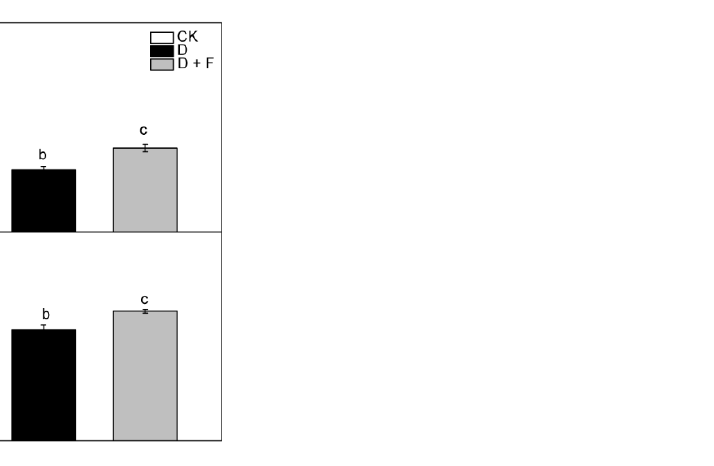
Figure 1. Aboveground biomass ( a ) and leaf relative water content ( b ) in leaves of B. napus treated with different fullerol treatments (0 and 100 mg L − 1 F) and water gradients (CK: check, sufficient water condition; D: drought). Values are the means of three replicates ± standard error. The different letters in each subfigure indicate significant differences between water or fullerol treatments. Data were adapted from Xiong et al. [9].